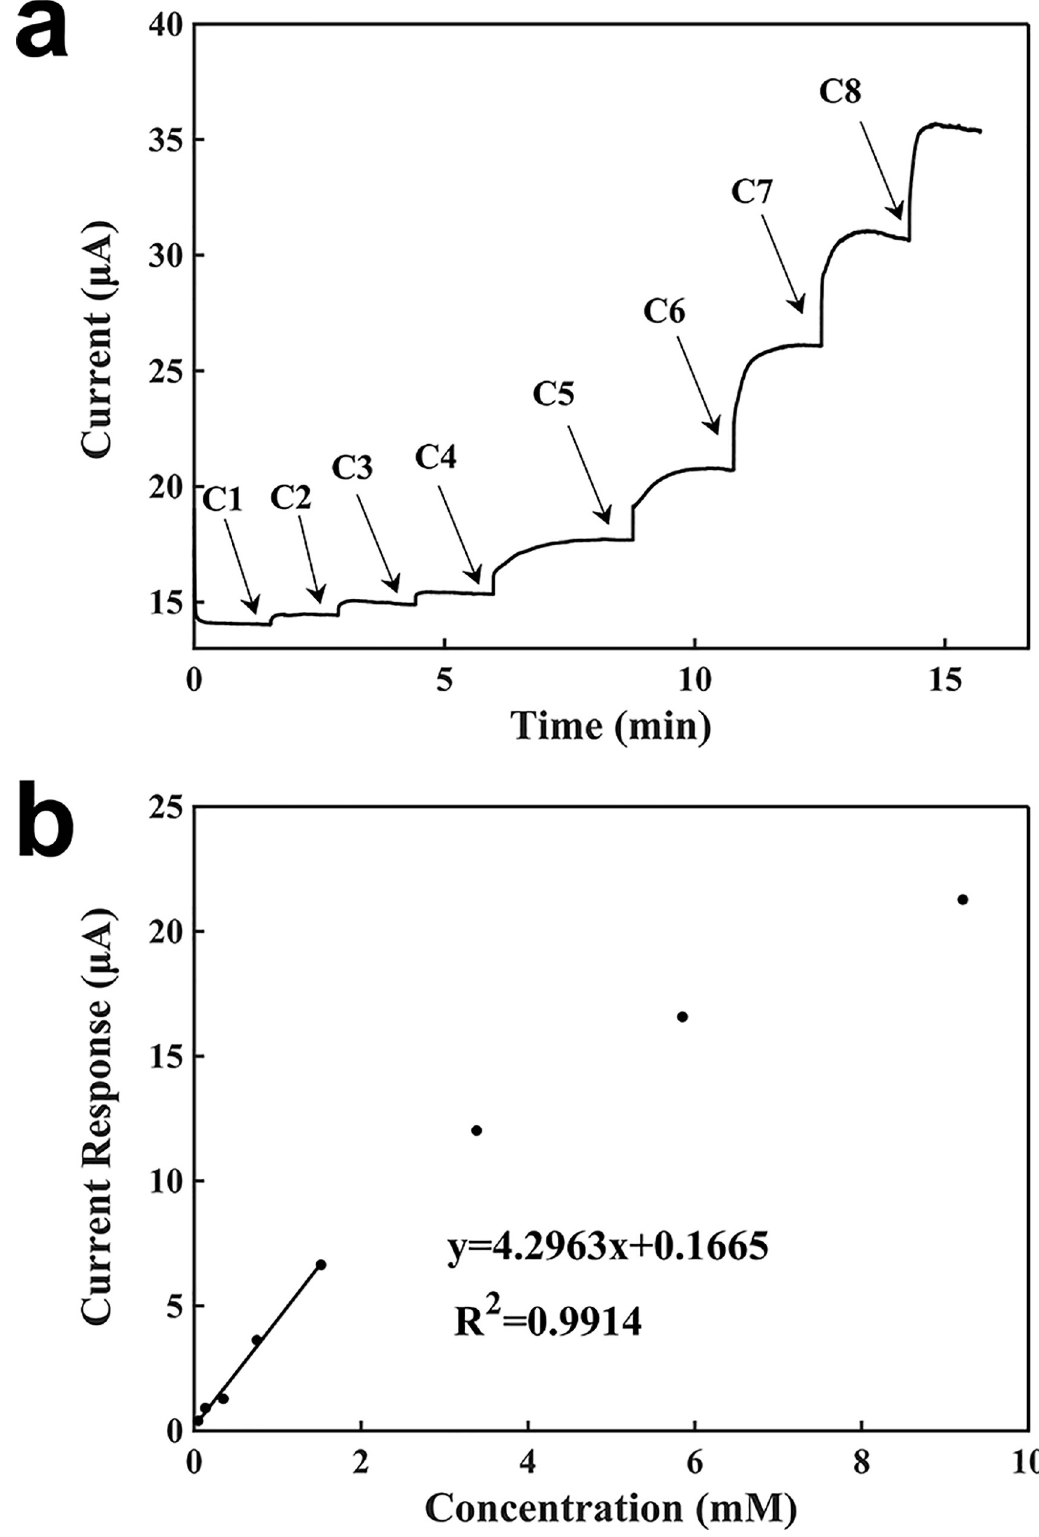
Fig 6. Characterization of the sensor for the detection of lactate using a potentiostat. (a) Current-verses-time response curve upon the additions of lactate. C1: 0.04762mM, C2: 0.08875mM, C3: 0.21146 mM, C4: 0.40217 mM, C5: 0.77000 mM, C6: 1.86462 mM, C7: 2.46724 mM, C8: 3.36243 mM. (b) Calibration curve for the detection of lactate.